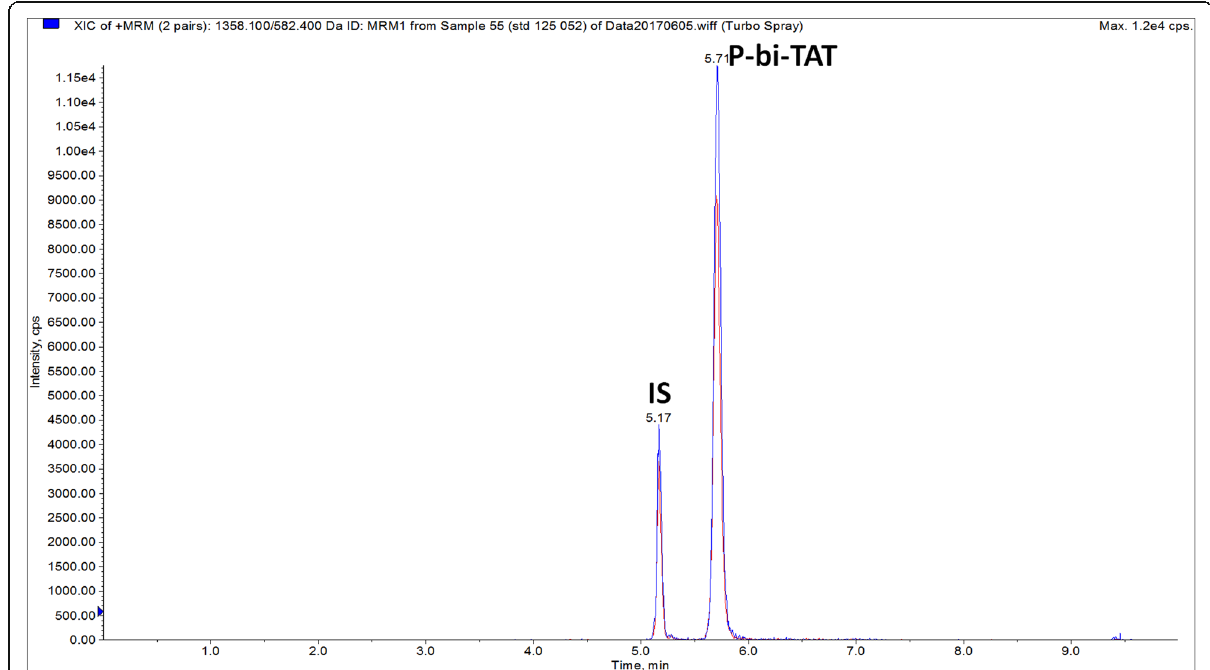
Fig. 5 Typical LC-MS/MS for P-bi-TAT (5.7 min) and IS (5.2 min) in positive